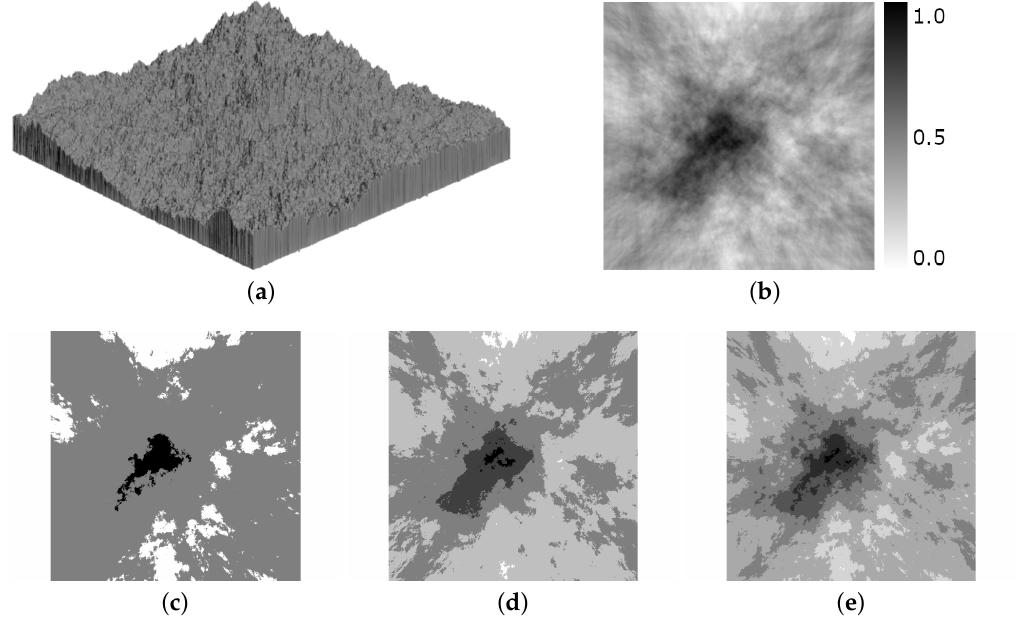
Figure 9. Materials layer generated by the Linear Fault Formation (LFF) method interpreted as a grey-scale map (grid resolution: 1024 × 1024; fault height (each): ∆ h = 1; total faults: 9999). ( a ) Geometric layer. ( b ) Initial map. ( c ) mat = 3. ( d ) mat = 5. ( e ) mat = 7.